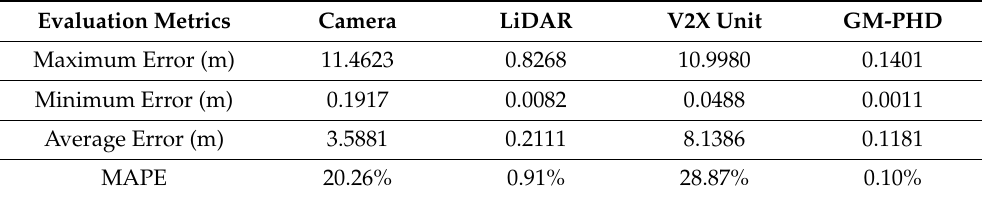
Table 6. Performance of the GM-PHD model and the single-sensor model under maximum error, minimum error, average error, and MAPE evaluation metrics.